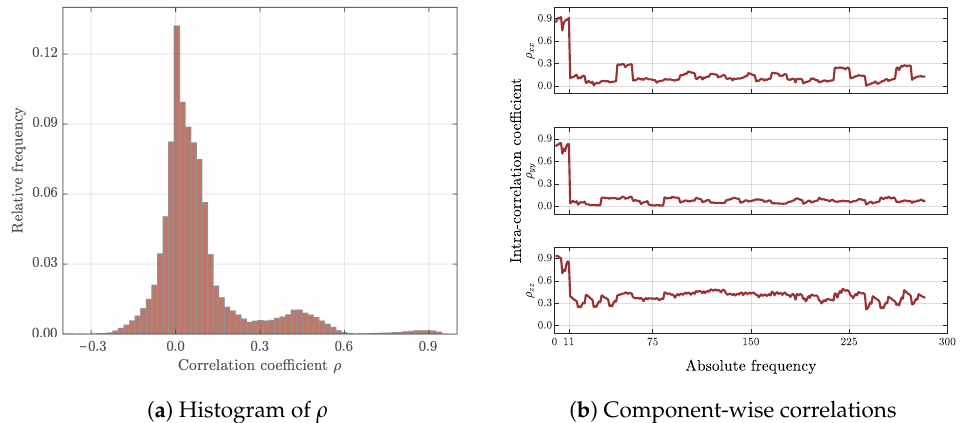
Figure 9. Frequency of correlation coefficients for the observed positions, exemplified for DOY: 260. Whereas the histogram ( a ) contains the full set of correlation coefficients, in ( b ) component- wise intracorrelations ρ x , ρ y , and ρ z of an arbitrary position are depicted. Self-correlations are i x j i y j i z j excluded in both